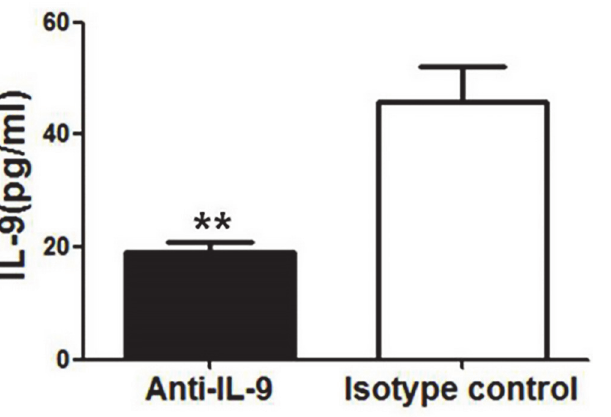
Fig 4. Intranasal delivery of anti-IL-9 mAb successfully neutralized IL-9 in the lung. C57BL/6 mice were intranasally administered with 10 μ g of either anti-mouse IL-9 mAb or isotype control antibody at day -1 (one day before), day 0, day 2 following Cm (1×10 3 IFUs) lung infection. On day 3 post-infection, mice were sacrificed and lung homogenates were prepared to detect IL-9 protein by ELISA. One representative experiment of two independent experiments (four mice in each group in each experiment) is shown. The results are shown as mean ± SD ( ** , p < 0.01).